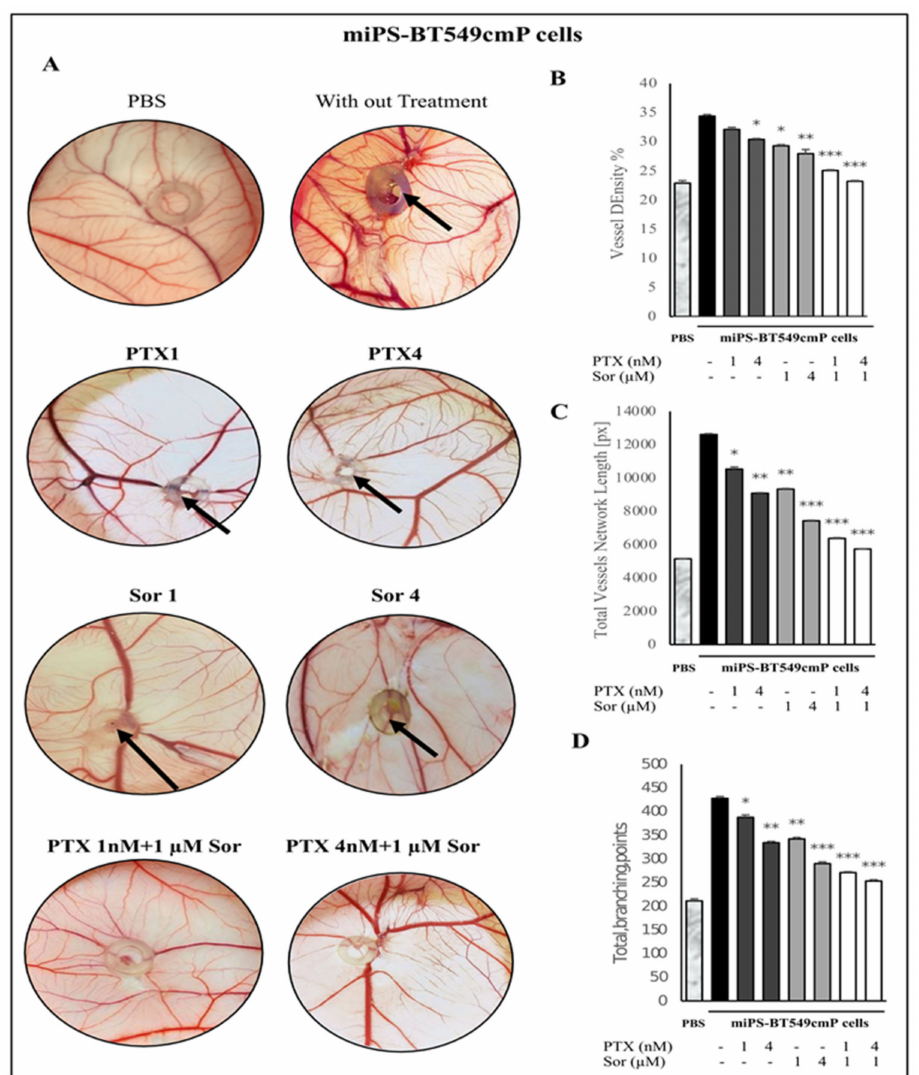
Figure 8. In vivo CAM assay. ( A ) Macroscopic observations of the antiangiogenic e ff ect of combined treatment of PTX and Sor on miPS-BT549cmP cells. Numerous allantoic vessels converge radially around non-treated controls. Following combined treatment with PTX and Sor, evident reduction in neovessel formation compared with single treatment groups. In addition, inhibition of tumor formation was found in combined groups compared with single treatment groups (black arrow). ( B – D ) Analysis of photographs from ( A ) of the vessel density ( B ), total vessel length ( C ), and number of branching points of the vessels ( D ) of the CAM illustrating the anti-angiogenic e ff ect of single or combined treatment of PTX and Sor of miPS-BT549cmP